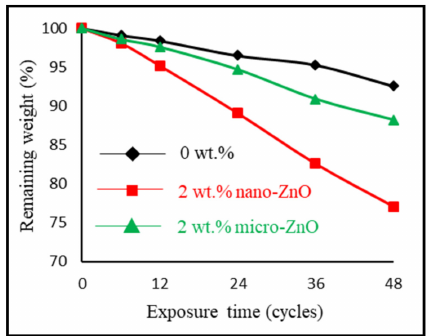
Figure 7. Weight changes of coatings with (2 wt.%) or without (0 wt.%) ZnO particles, during the UV/CON aging.